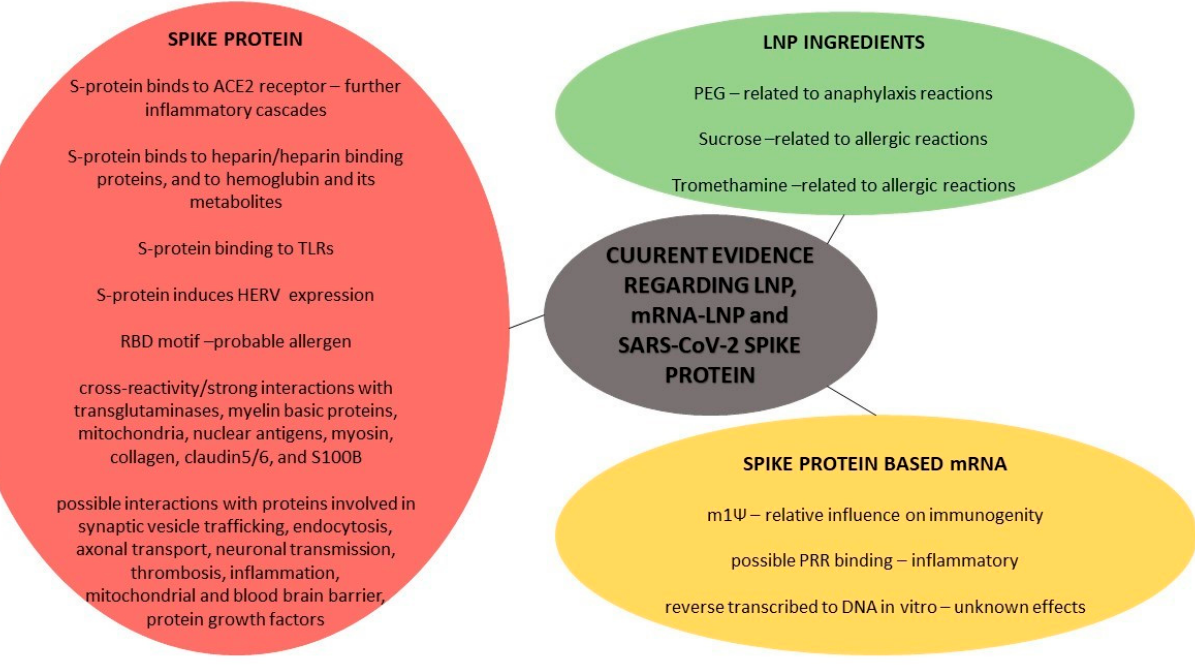
Figure 2. Summary of the current most common evidence regarding LNP, SARS-CoV-2 spike protein- based mRNA and spike